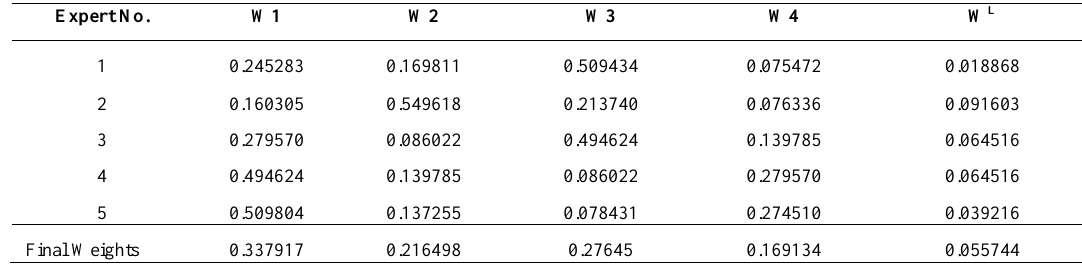
Table 4. Determine the weight of criteria